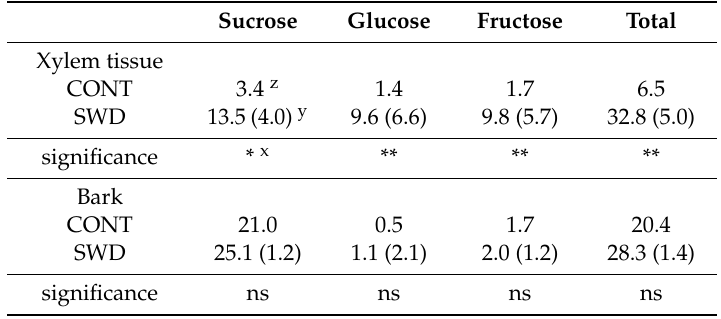
Table 3. E ff ect of SWD treatment on sugar compositions of xylem and bark in sca ff old branch of Meiwa kumquat.